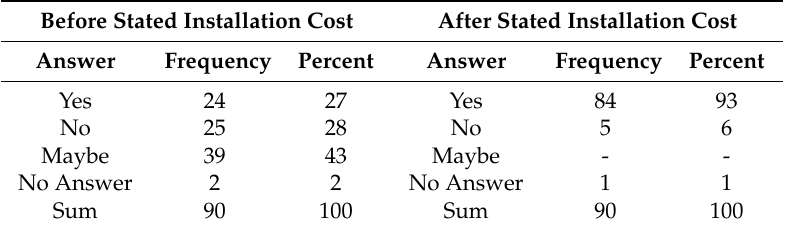
Table 1. Farmers’ willingness to entertain adoption estimates for water quality trading program before and after stated conservation practice installation